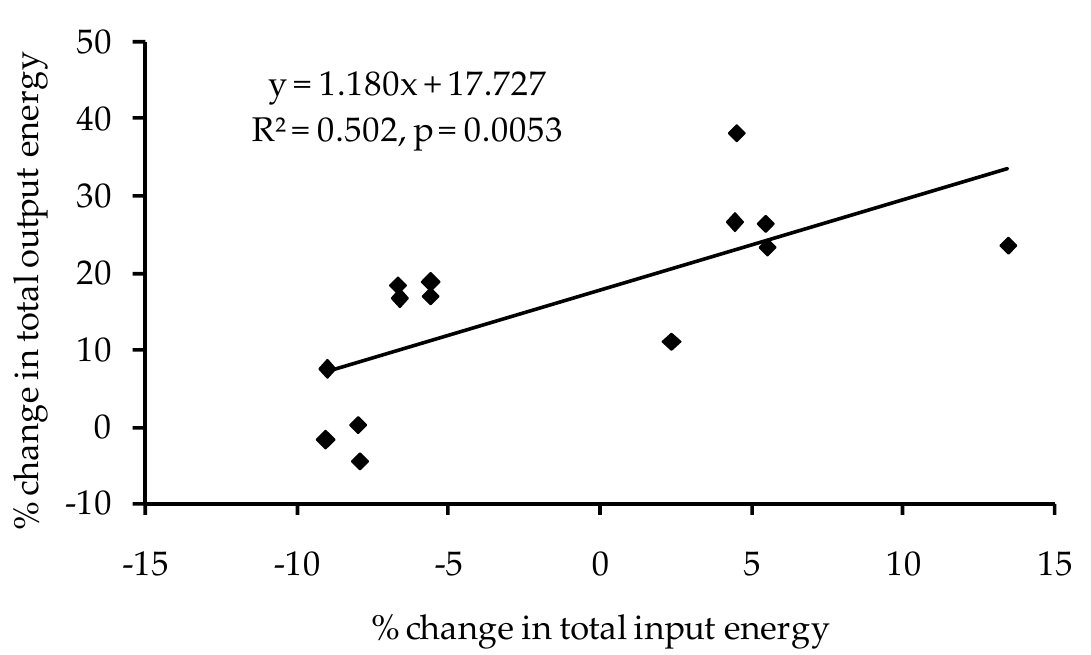
Figure 1. The relation between input and output energy in the rice–maize–green gram system.